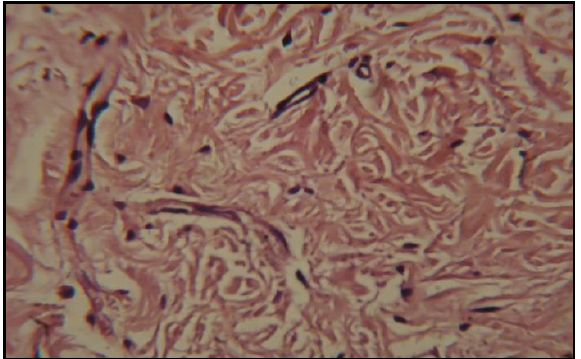
Figure, 7: Histopathological section in fibroma of (Fig. 6) at high magnification shows The tumor cells are fusiform, stellate in shape and have large, pale ovoid to elongated nuclei, mitotic figures are rare (H and E